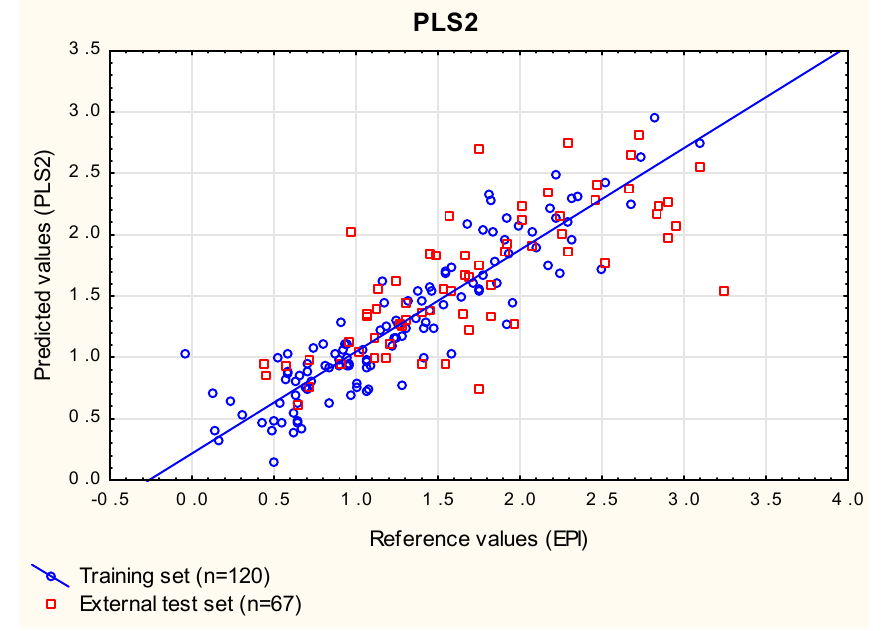
Figure 5. PLS2 model—predicted vs. reference log BCF values. Table 3. Summary of MLR, PLS and ANN models developed in this